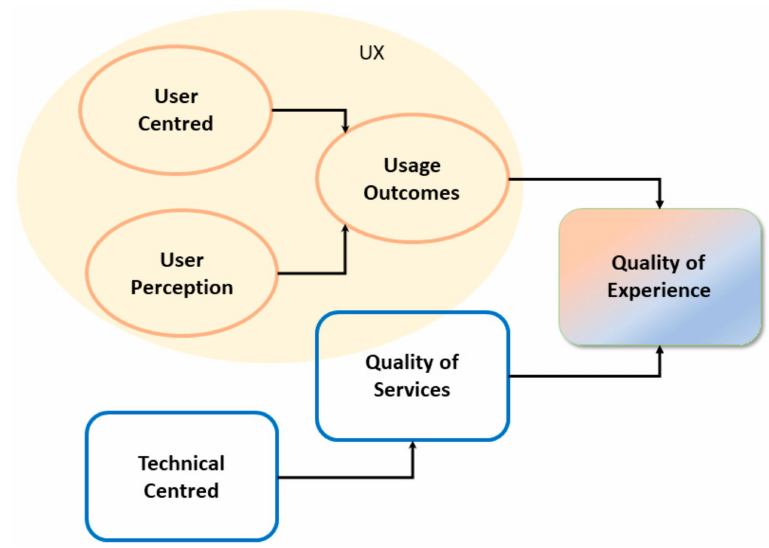
Figure 1. Elements of UX and